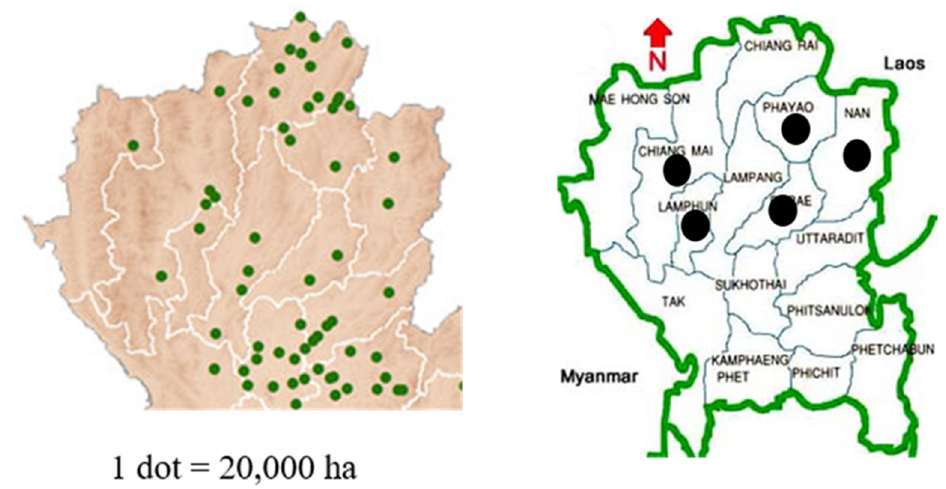
Figure 1. Rice plating areas in Northern Thailand ( left ) (Ricepedia.org) and locations of the Thai Meteorological Department (TMD) (black dot) ( right ).